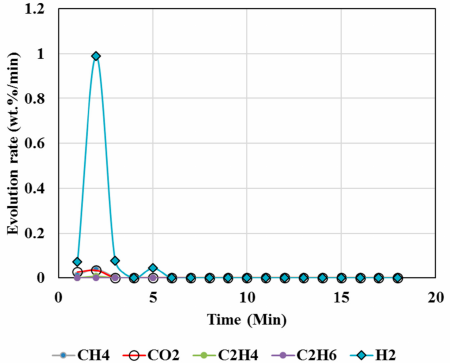
Figure 6. Gas Chromatography results of isothermal calcination of magnesite + plastics + biomass (Test 7, MgCO 3 · xH 2 O; biomass; resin) at 1000 ◦ C.